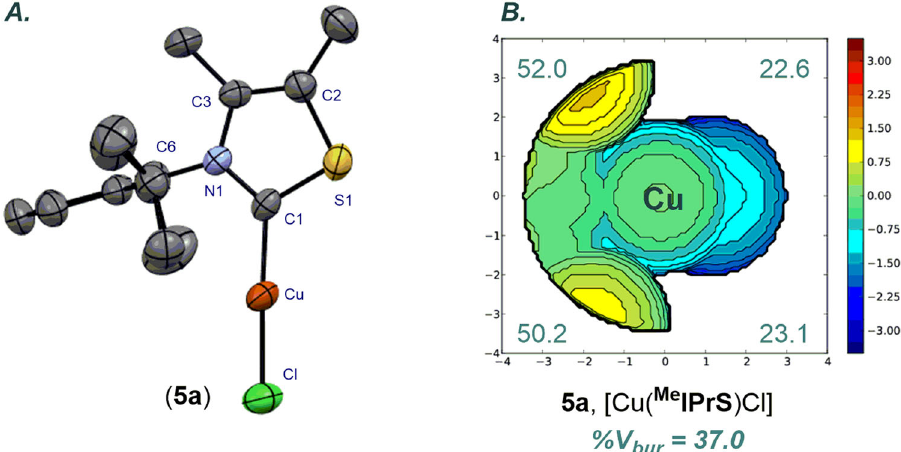
Fig. 6 X-ray crystal structure and Topographical steric map. A X-ray crystal structure of complex ( 5a ). Hydrogen atoms have been omitted for clarity. Selected bond lengths [Å] and angles [°]: Cu – C1, 1.871(2); Cu – Cl, 2.0947(7); C1 – N1, 1.338(2); C1 – S1, 1.700(2); C6 – N1, 1.460(3); N1 – C3, 1.402(3); S1 – C2,